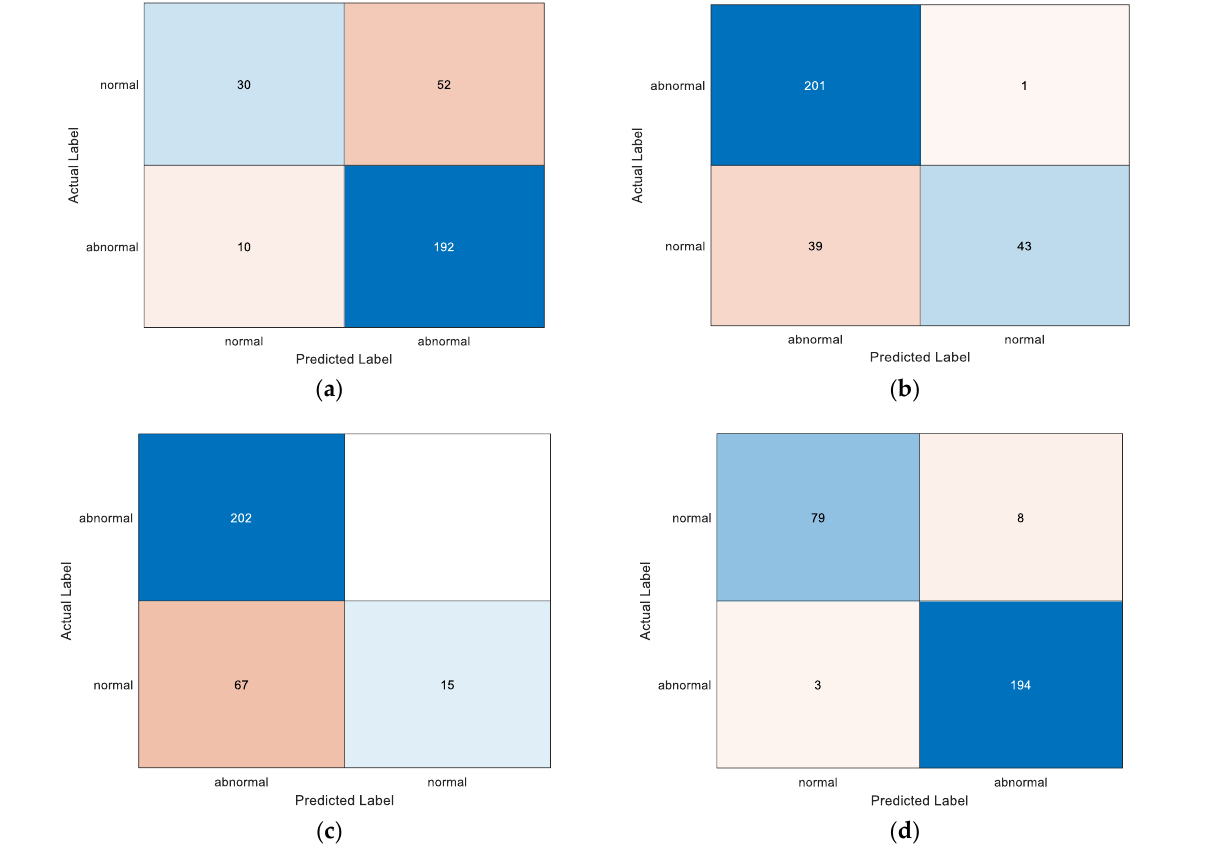
Figure 12. Confusion matrix obtained by different models: ( a ) ECG-PCG-BiLSTM; ( b ) ECG-GoogLeNet; ( c ) PCG-GoogLeNet; ( d ) BiLSTM-GoogLeNet-DS.